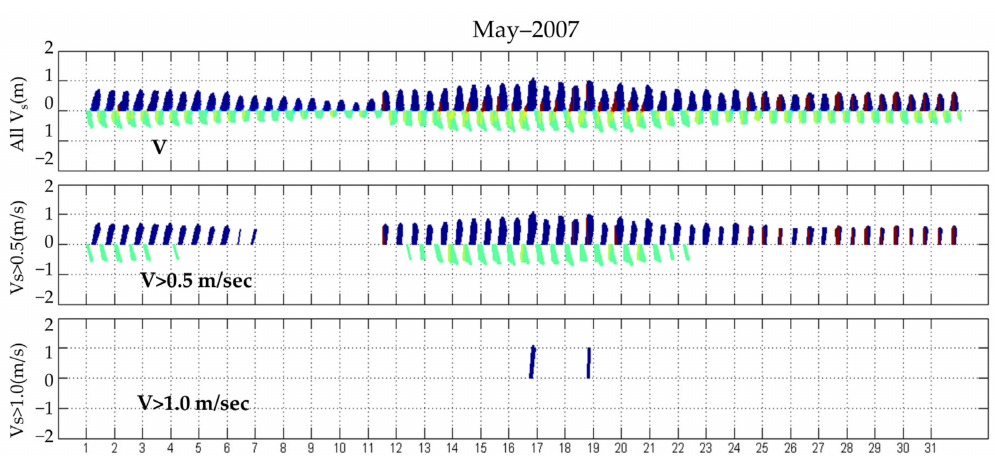
Figure 14. Current velocity vector diagram (1-month data).